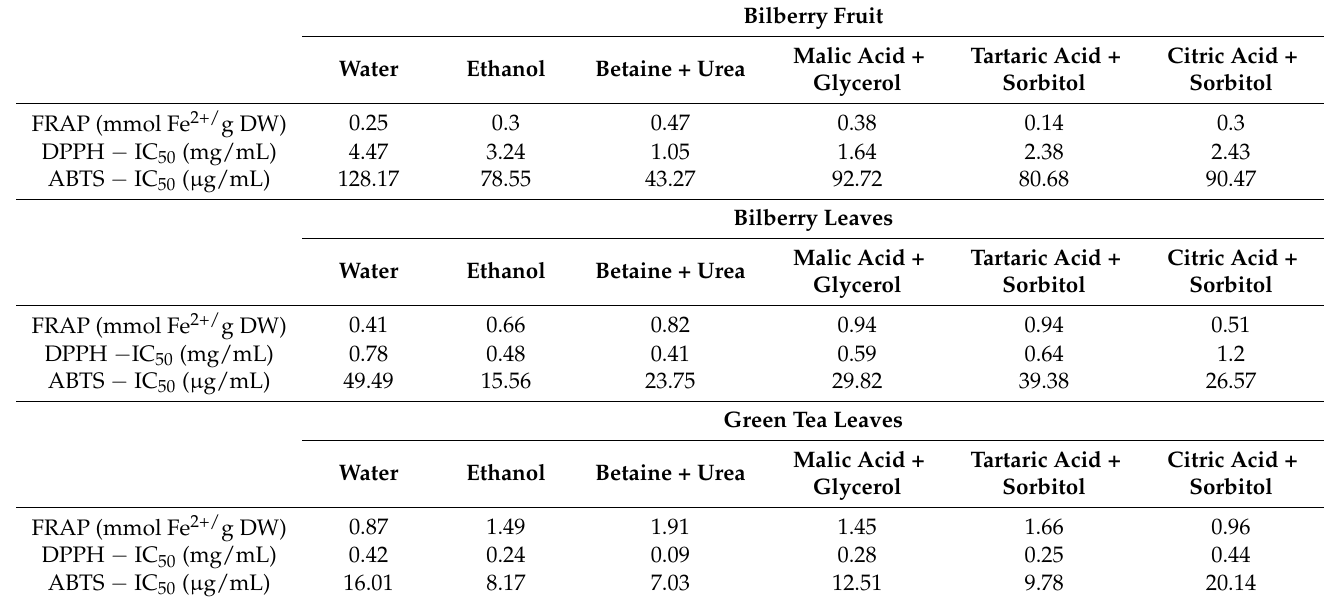
Table 4. Antioxidant activity of the investigated extracts.